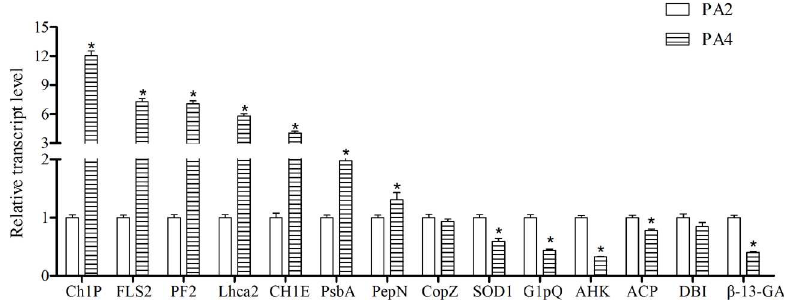
Fig 6. The expression of selecteddifferentially abundant proteins at mRNA level. The 18S rRNA of Paulownia was chosen as an internalreference genefor normalization. ChlP: geranylgeranyl reductase, FLS2: LRR receptor-likeserine/threonine-protein kinase FLS2, PF2: plastidfibrillin 2, Lhca2: light-harvesting complex I chlorophylla/b bindingprotein 2, ChlE: magnesium-protoporphyrin IX monomethylester (oxidative) cyclase, PsbA: photosystem II P680 reaction center D1 protein, PepN: amino peptidase N, CopZ: copper chaperone, SOD1: Cu/Zn superoxide dismutase, GlpQ: glycerophosphoryldiester phosphodiesterase, AHK: arabidopsis histidinekinase, ACP:acid phosphatase, DBI: diazepam-bindinginhibitor, β -1,3-GA: beta- 1,3-glucanase. Error bars represent the standarderror of the mean. * : Statistically significantdifferences betweenPA2 and PA4 ( P <